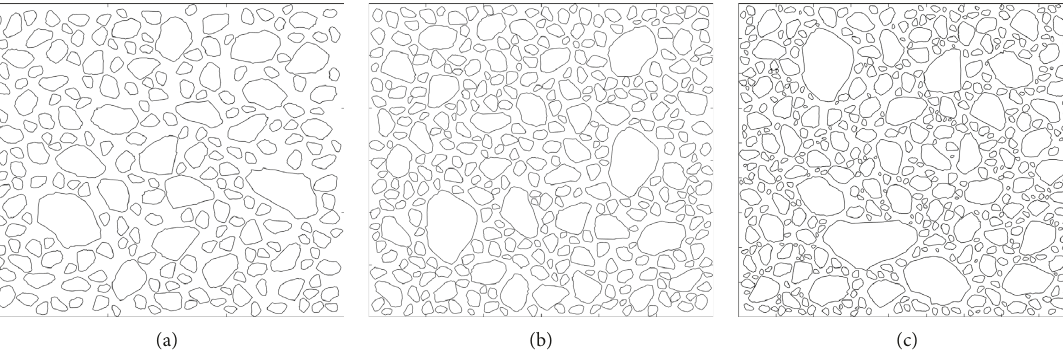
Figure 5: Aggregate generation by gradation. (a) Two-gradation, aggregate content 45.42%. (b) Three-gradation, aggregate content 52.17%. (c) Four-gradation, aggregate content